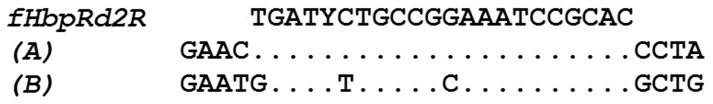
Conservation of the fHbpRd2R primer binding site.Single dots denote bases matching that of the PCR primer (Top sequence, 3′–5′ direction). Sequence A is representative of 438/443 (98.8%) meningococcal isolates aligned (Table S2). Sequence B features the fHbpRd2R primer site mismatch. This was found in two isolates within the MGL (0.22%) and 25% of N. lactamica sequences aligned.